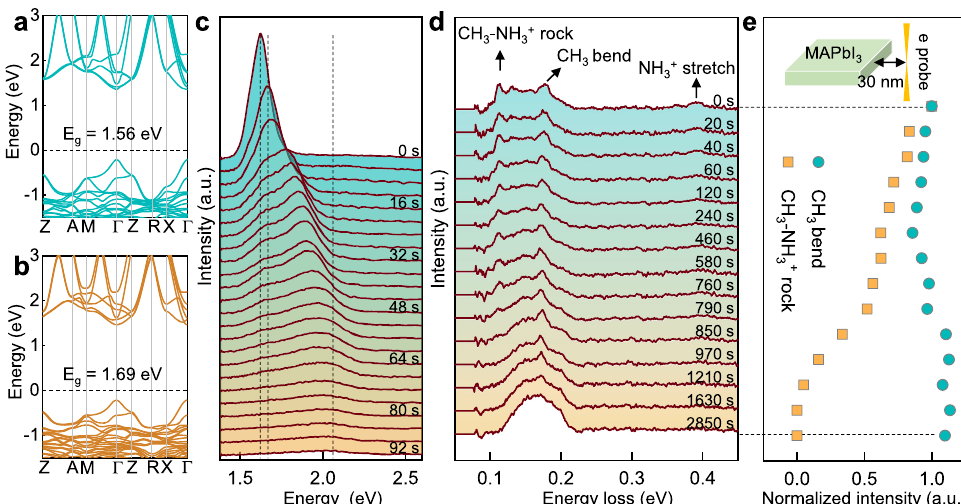
Fig. 3 Electronic structure and chemical bonding evolutions during the degradation. a, b Electronic structures of MAPbI 3 and MA 0.5 PbI 3 . The Fermi level is set to zero. c Time-series CL spectra showing the bandgap gradually increases from 1.6 eV to 2.05 eV. The dashed lines show the calculated bandgaps at 1.56, 1.69 and 2.15 eV for MAPbI 3 , MA 0.5 PbI 3 and 6H-PbI 2 , respectively. d Time-series vibrational spectra under ‘ aloof ’ mode with the electron probe ~30 nm away from MAPbI 3 . Black arrows indicate the peaks related with CH 3 -NH 3 + rock, CH 3 bend and NH 3 + stretch. The background was subtracted by the power-law function. e Evolutions of normalized intensities of CH 3 bending (cyan circles) and CH 3 -NH 3 + rock (orange squares) during the degradation. Inset is the schematic diagram of ‘ aloof ’ mode showing the electron probe is ~30 nm away from MAPbI 3 for the vibrational spectroscopy